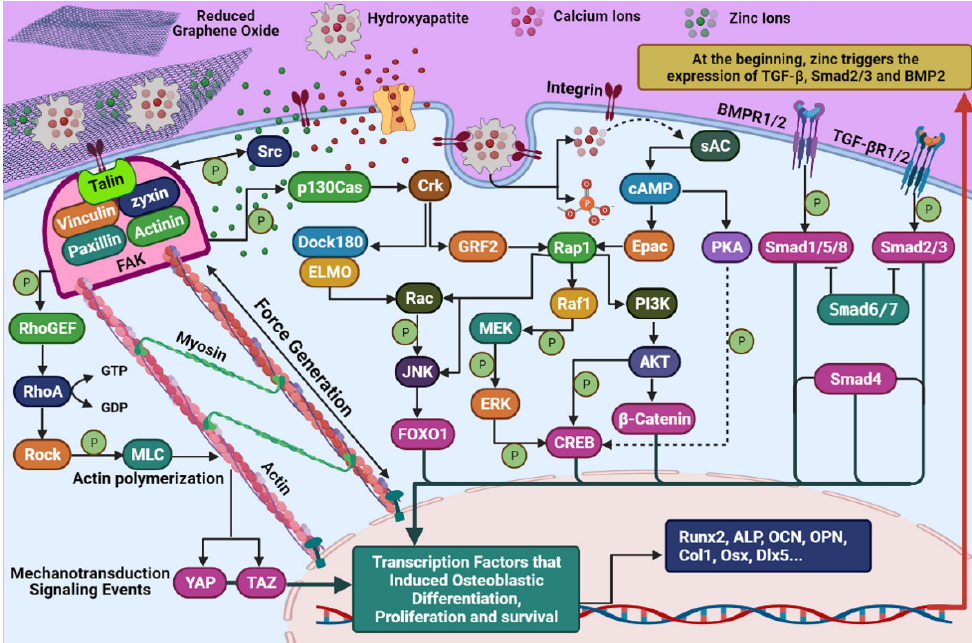
Figure 9. Schematic representation of ZnHA-rGO nanosystem interactions with MSC. The illustration shows the molecular mechanism of proliferation modulation and osteogenic differentiation of MSC by the ZnHA-rGO nanosystem through signaling pathways.